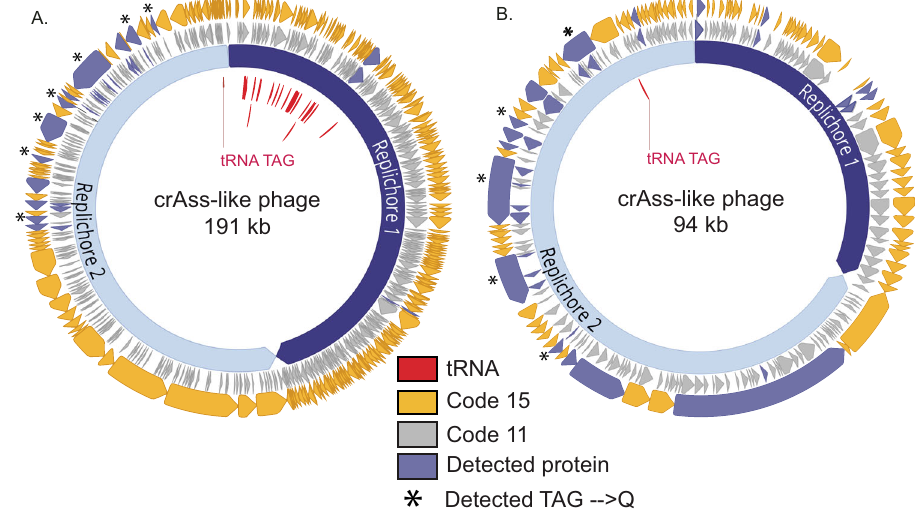
glutamines encoded by reassigned TAG codons, and these genes with these vali- dated recoding events are marked with stars. Suppressor tRNAs (red labels) are predicted to suppress translation termination at recoded TAG stop codons. Indi- vidual replichores were identi fi ed based on GC skew patterns indicative of bidir- ectional